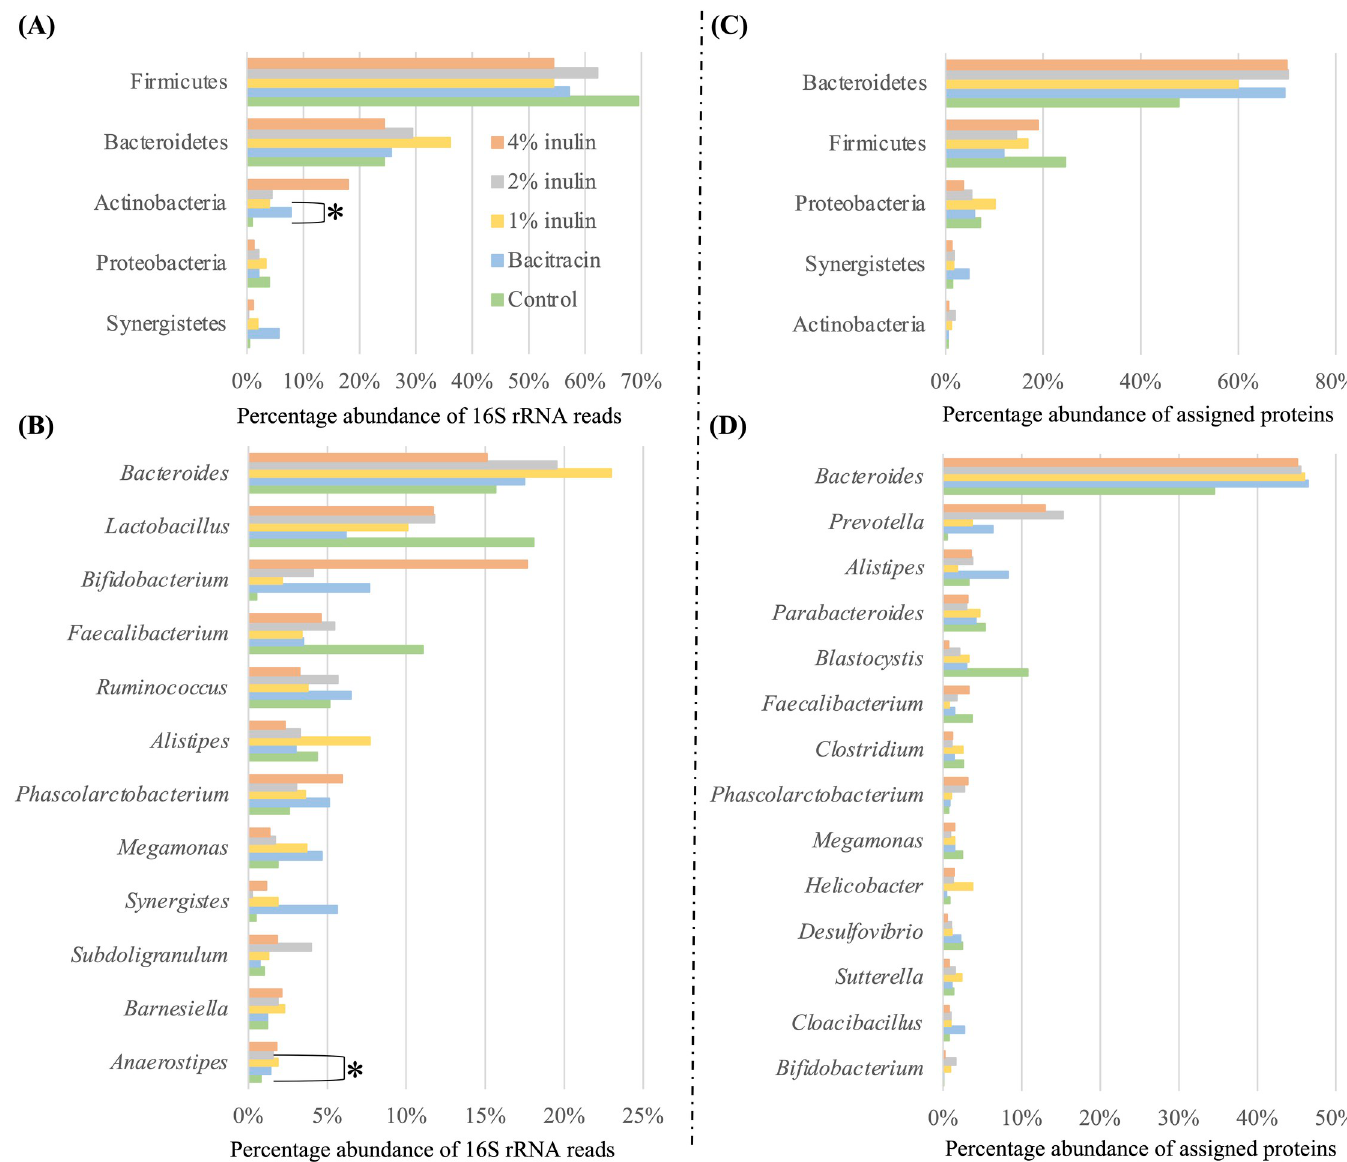
Fig 2. Phylum (A) and genus (B) compositions of the bacterial communities in the cecal microbiota characterized based on 16S rRNA amplicons (V3-V4 region) sequencing. Relative expression abundance of assigned proteins at phylum (C) and genus (D) level based on transcriptome analysis of the cecal microbiota. Symbol labels in (A) apply to (B), (C) and (D). � significant ( P < 0.05) difference between two dietary